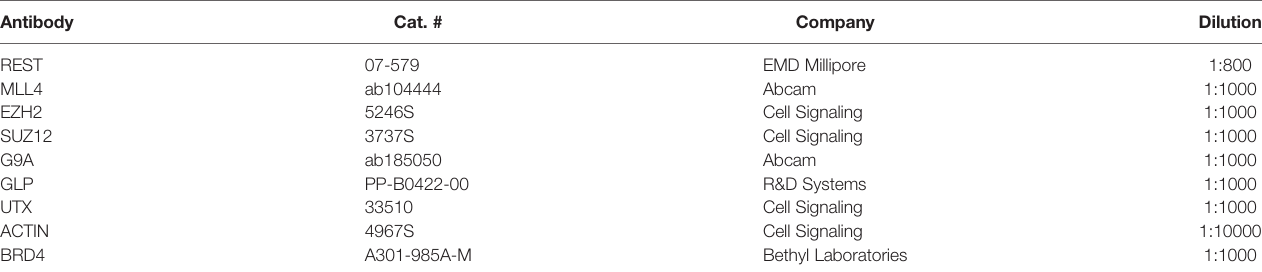
TABLE 3 | Antibodies for Western Blot. Antibody Cat.